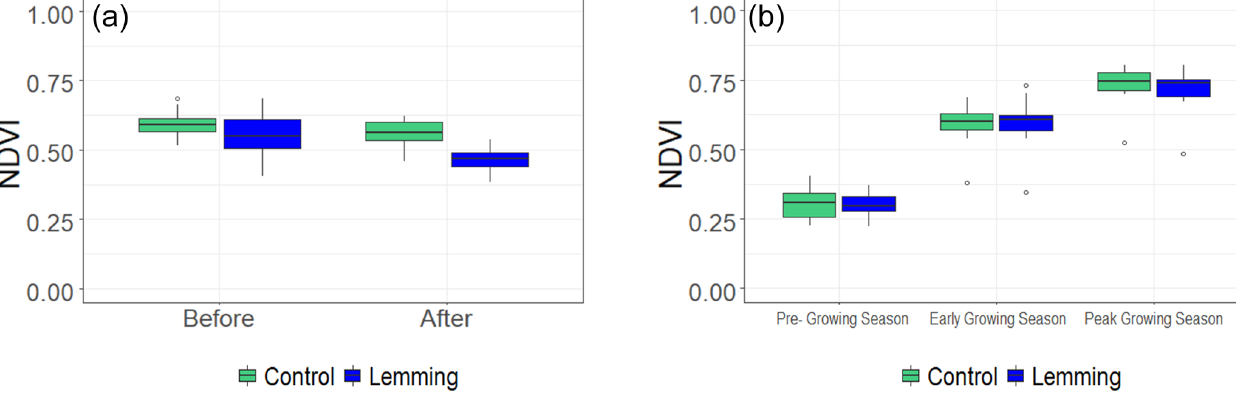
Figure 5. Box and whisker plots of 2018 and 2019 NDVI values for control and lemming plots. (a) Median NDVI for plots before and after the experiment in summer 2018 ( T = − 3 . 69, P = 0 . 015), and (b) median NDVI for plots during the three rounds of measurements in summer 2019 ( T = 0 . 41, P = 0 . 692). Higher vascular plant green biomass in the pre-lemming treatment plots presented NDVI values in the 0.6–0.7 range, whereas post-lemming treatment plots in 2018 exhibit NDVI values around